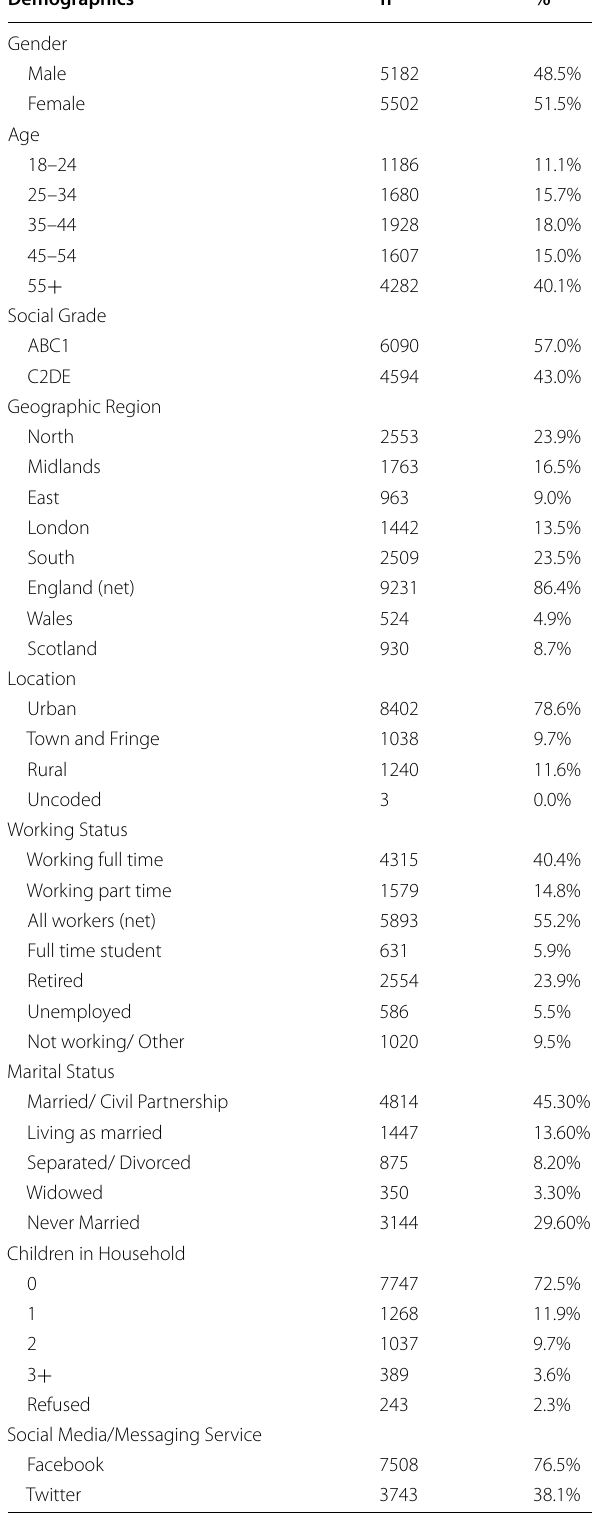
Table 1 Demographic data of survey